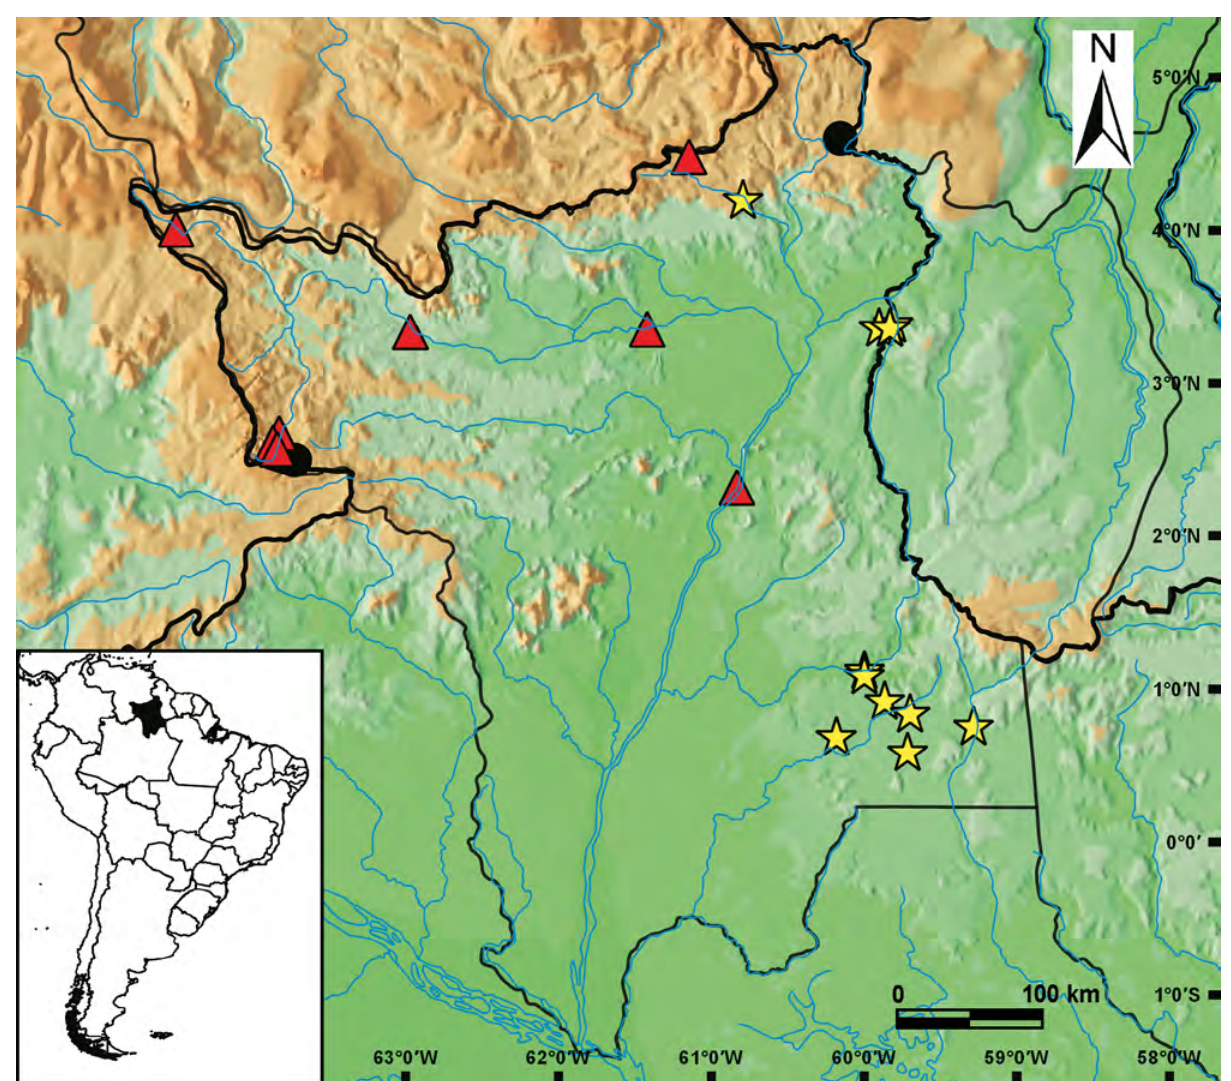
Figure 4. Distribution of the pseudothelphusid species, Fredius fittkaui (Bott, 1967) (circle), F. stenolobus Rodríguez and Suárez, 1994 (triangle), and Kingsleya latifrons (Randall, 1840) (star), in the state of Roraima,